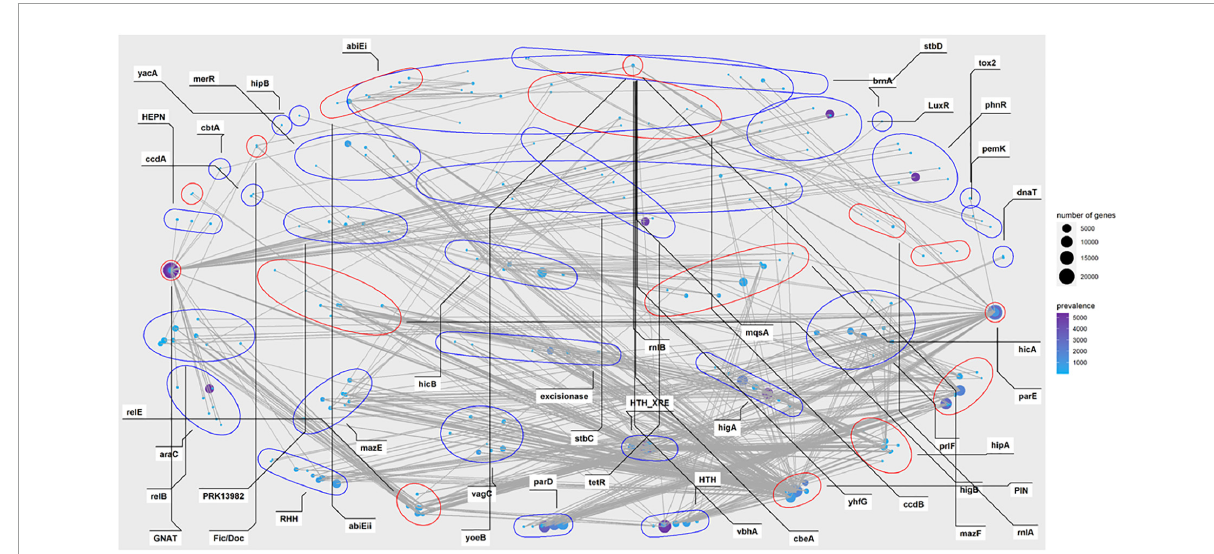
FIGURE3 Prevalence network of the type II toxin-antitoxin (TA) grouped by gene family or domain in P. aeruginosa population. The nodes represent TA homologs from different loci, with locus names in circles. The size indicates the absolute count numbers of the corresponding locus. The prevalence of each locus (unique counts) among all strains are highlighted in the color scale. The red circles represent toxin components while the blue ones represent antitoxins. TA systems with a prevalence less than 10 were excluded.